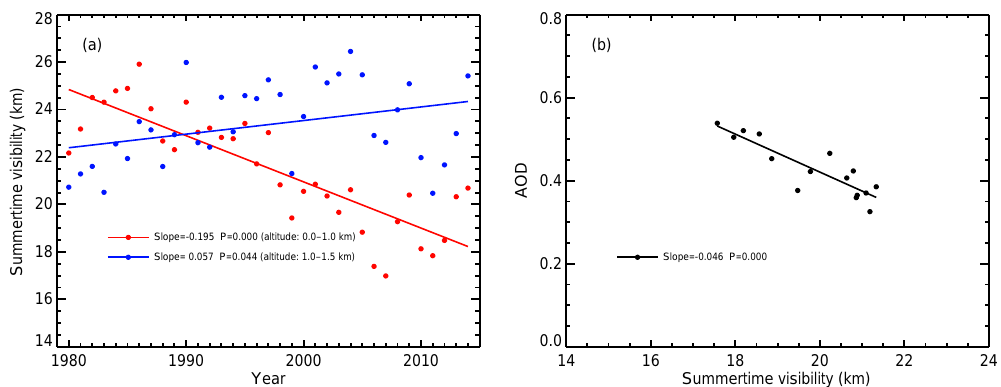
Figure 2. (a) Long-term trends in visibility measured at meteorological stations located at different altitudes on the Guanzhong Plain and in the surrounding mountain region. (b) Correlation between aerosol optical depth (AOD) and visibility over the plain.